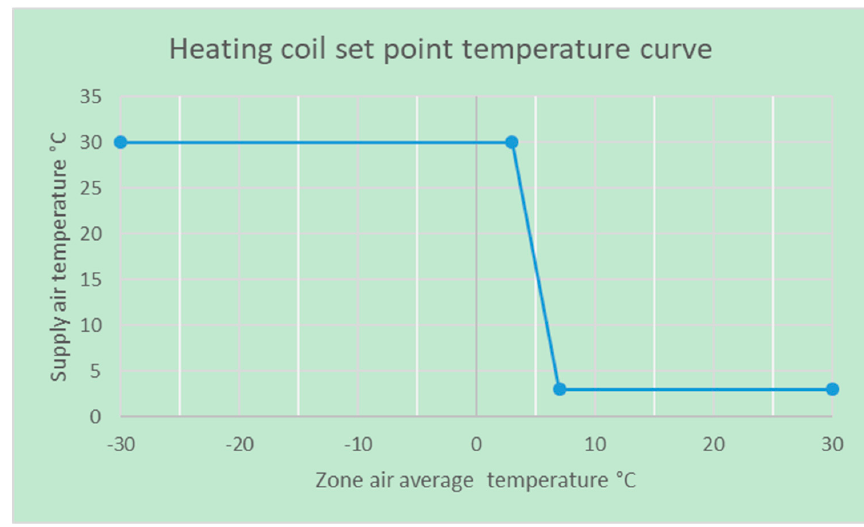
Figure 7. Heating coil set-point temperature curve to control the supply air.